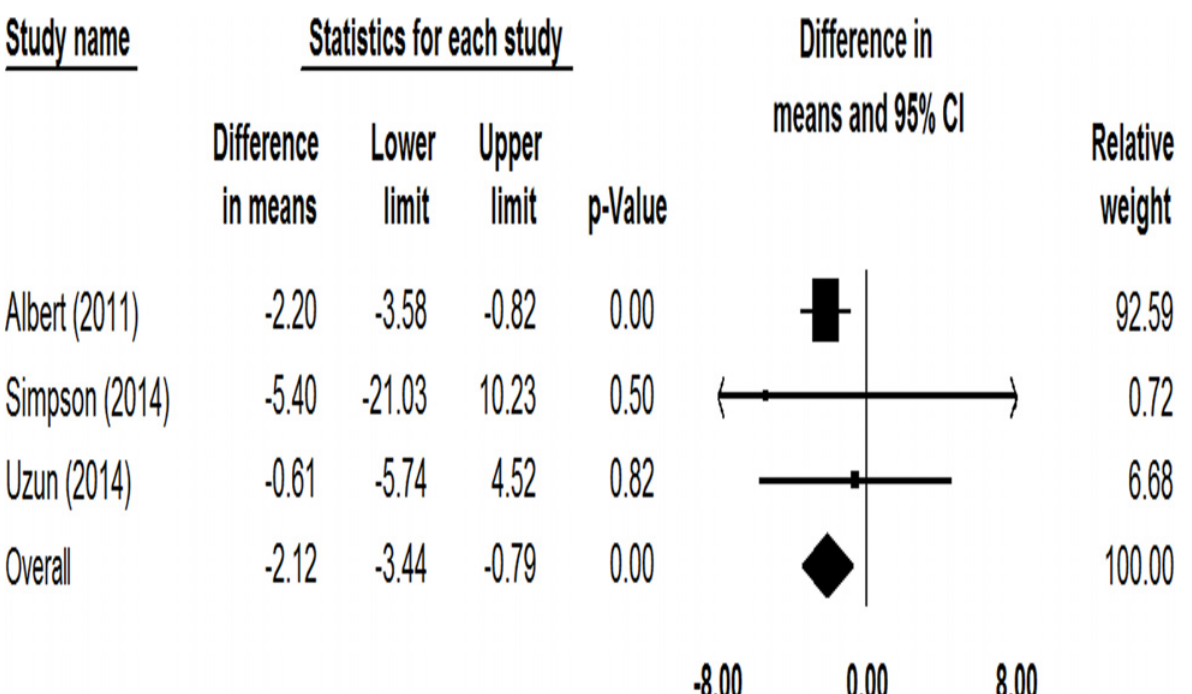
Fig 5. Forest plot of comparing the mean differences (MD) in change of SGRQ total score among COPD patients treated with macrolides compared with the control.